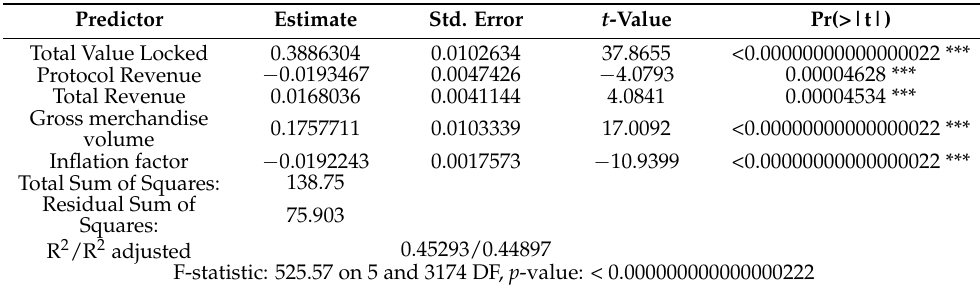
Table 8. Fixed Effects panel regression